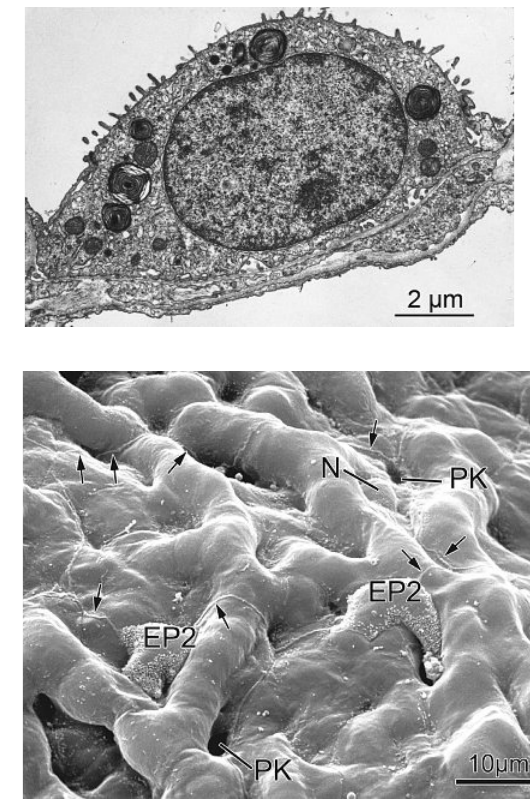
Figure 20 Type 2 alveolar epithelial cell as secretory cell for surfactant stored in lamellar bodies (black).